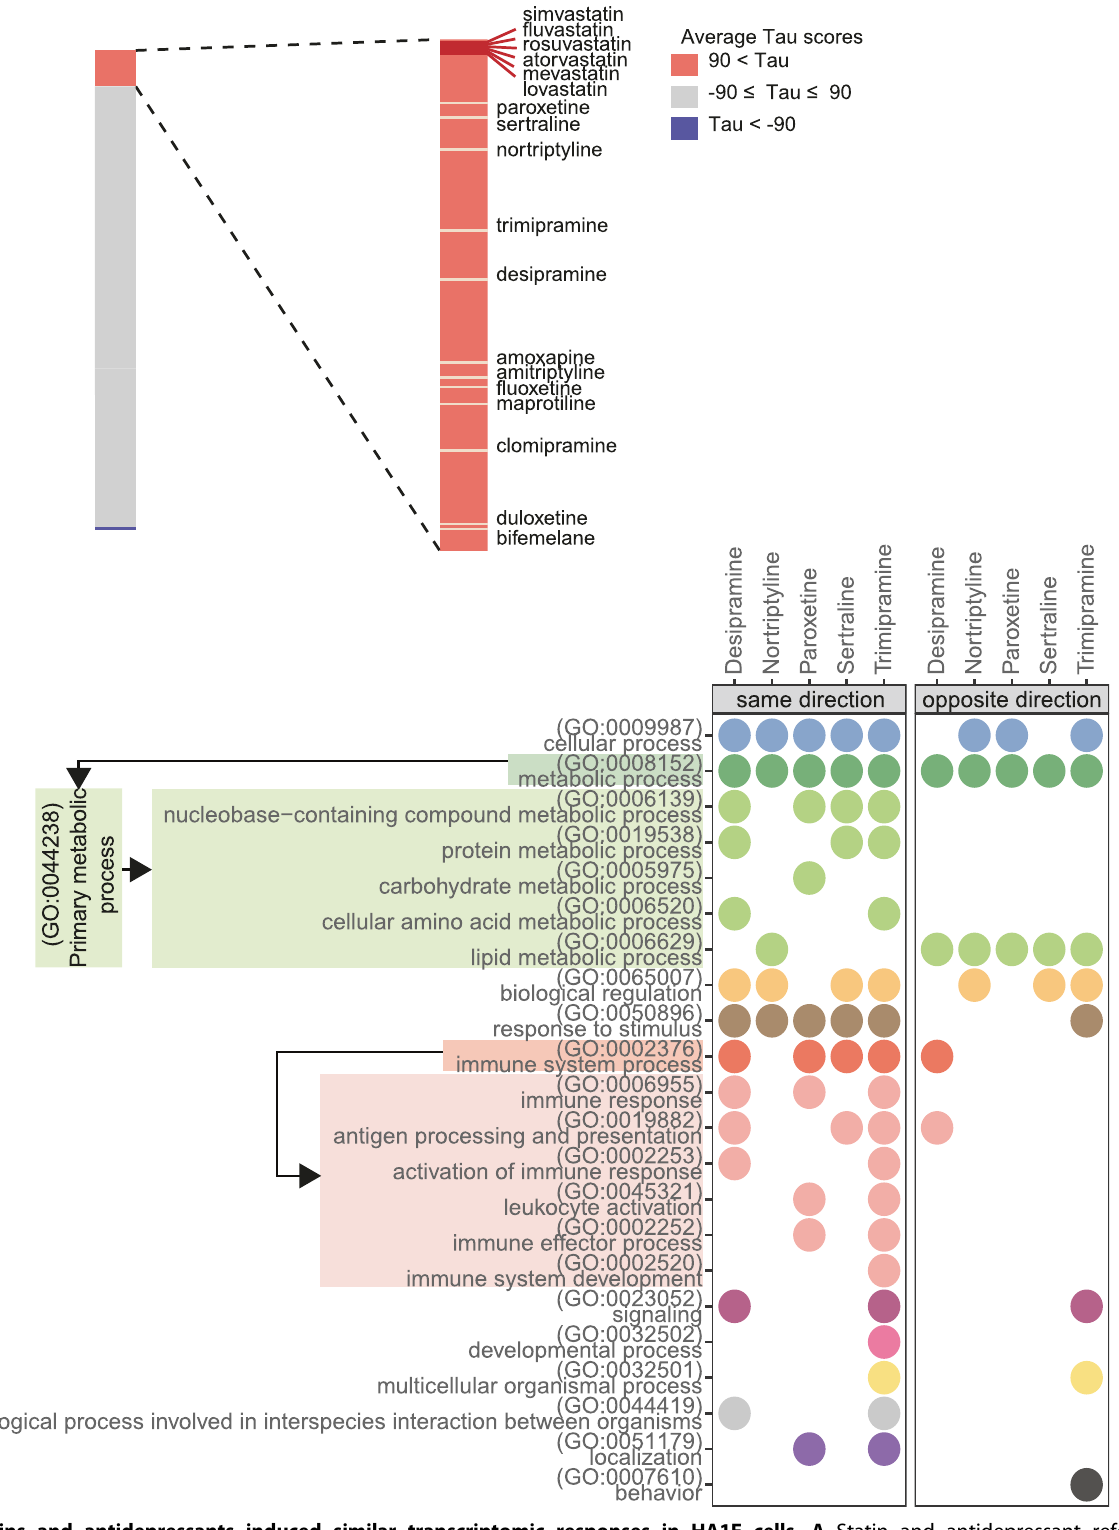
Fig. 1 Statins and antidepressants induced similar transcriptomic responses in HA1E cells. A Statin and antidepressant reference signatures ranked by average connectivity (Tau) scores to the six statin query signatures. Lengths of the coloured bars represent the number of compounds with the corresponding average Tau scores (red: Tau > 90; grey: − 90 ≤ Tau ≤ 90; blue: Tau < − 90). Antidepressants with an average Tau score higher than 90 are shown. B Biological processes identi fi ed as signi fi cantly enriched among genes perturbed by both statins and antidepressants, in the same (left panel) and opposite (right panel) directions. Y -axis shows the ancestor GO biological process terms, as well as the child terms of primary metabolic process (GO:0044238) (a child term of “ metabolic process ” ) and immune system process (GO:0002376). Arrows indicate ancestor-to-child relationships between GO terms. The bubble plots show the antidepressants for which the biological processes were identi fi ed as signi fi cantly enriched (gSCS-corrected p -value < 0.05) in at least one statin-antidepressant pair. Translational Psychiatry (2023)